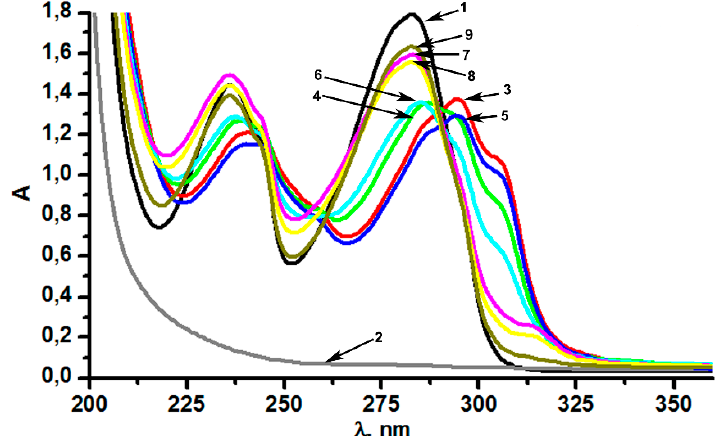
Figure 2. UV-Vis absorbance spectra in ethanol of: ( a ) 1—Co(bpy) 3 (BF 4 ) 2 (C = 1.67 × 10 − 5 mol · L − 1 ), Co II @SiO 2 (C = 0.2 g · L − 1 ) on the basis of Co II (bpy) 3 obtained by di ff erent techniques: 2—Stöber, 3—w / o; ( b ) 1—bpy (C = 5 × 10 − 5 mol · L − 1 ), 2—supernatant after Stöber synthesis diluted 10 times.